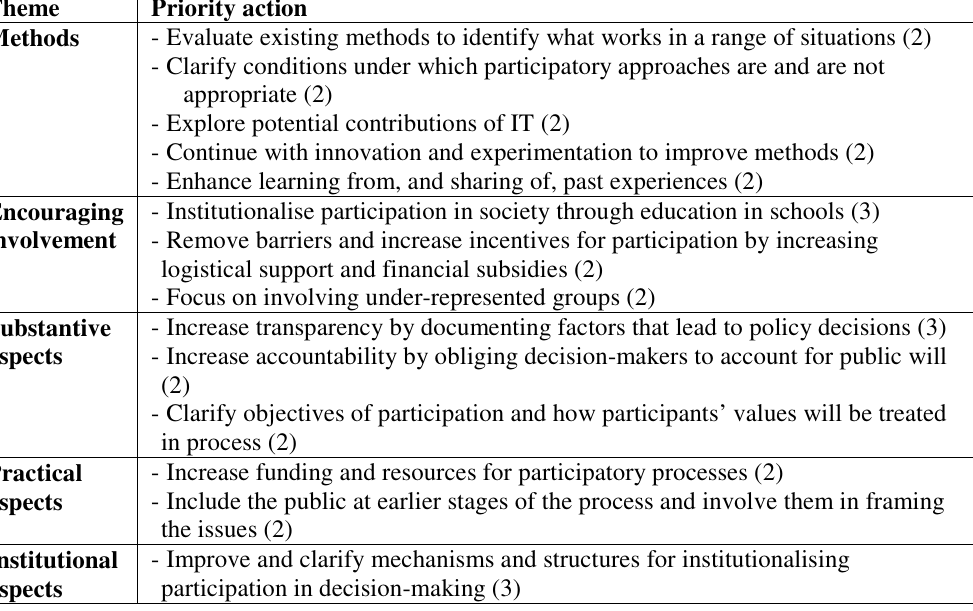
Table 2: Priority actions merged across the questions of effectiveness, representation and scale (number in parentheses indicates the number of categories in which the action was